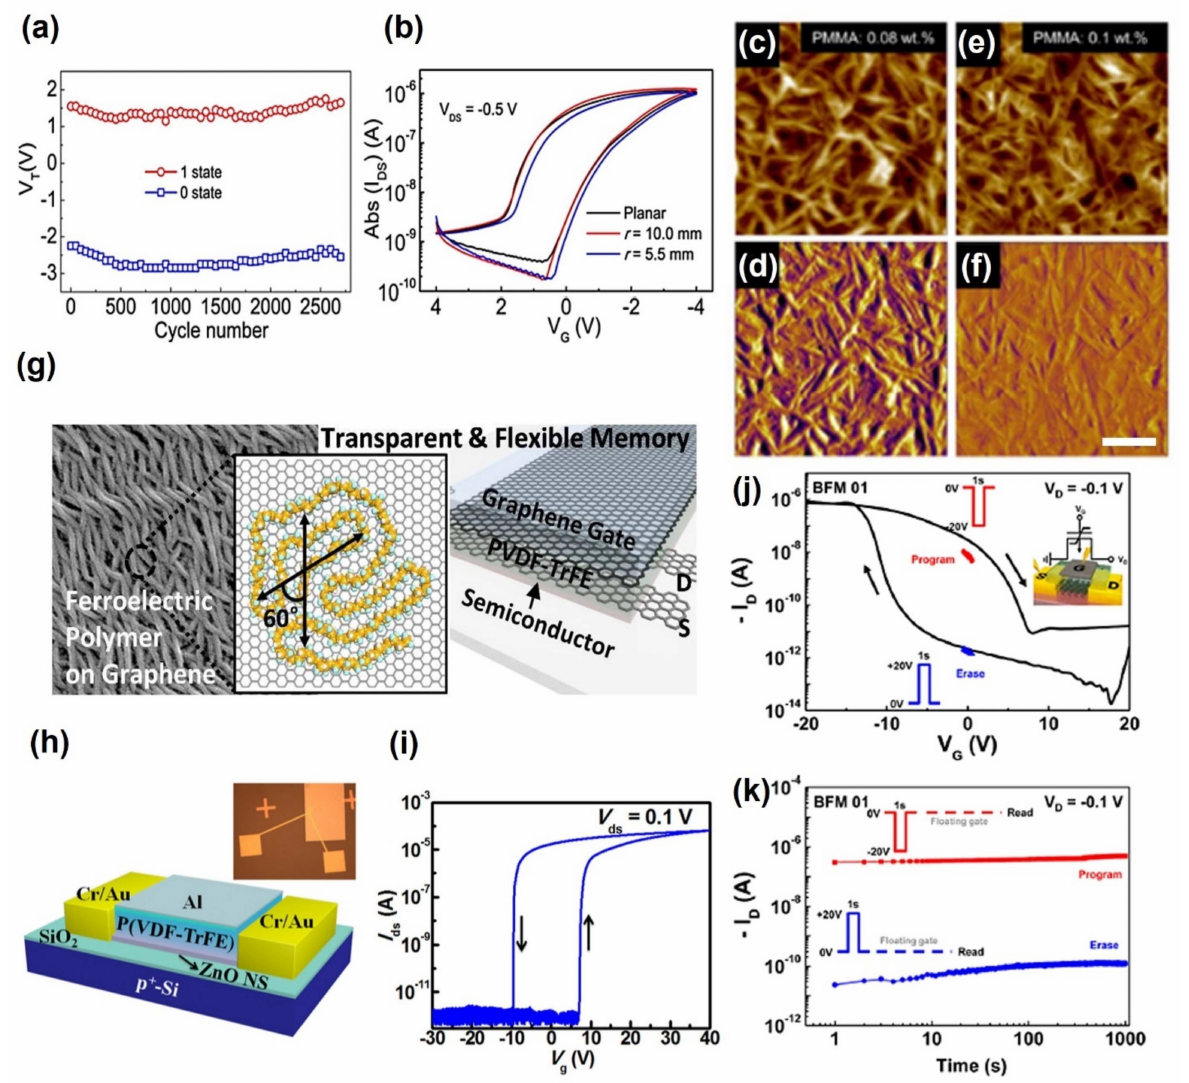
Figure 5. ( a , b ) Stable data storage retention over 8 × 10 4 s with a memory 10 2 of on-off in P(VDF-TrFE-CTFE) ferroelectric FETs (adapted from [84] with permission from Nature). ( c – f ) RMS roughness of the PMMA/P(VDF-TrFE) surface with increasing PMMA concentration from 0.08 wt. % to 0.1 wt. % (adapted from [86] with permission from the American Chemical Society). ( g ) Ferroelectric FETs using 2D materials; graphene (adapted from [87] with permission from the American Chemical Society) and ( j , k ) black phosphorus (BP) (adapted from [88] with permission from the American Chemical Society). ( h , i ) Structural and I–V characteristic curve of ferroelectric FETs using metal oxide (ZnO) (adapted from [89] with permission from AIP